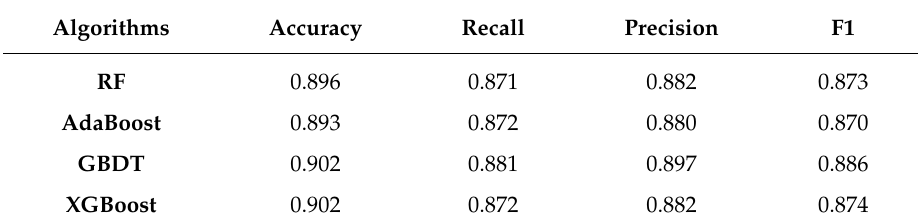
Table 10. Results of action identification on the UnionPay